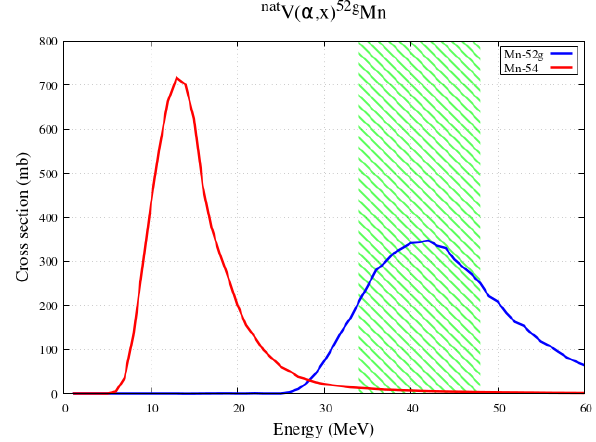
Fig. 3. Comparison between the optimized cross sections of 52g Mn and 54 Mn, and identification of a promising energy window for the production of high purity 52g Mn